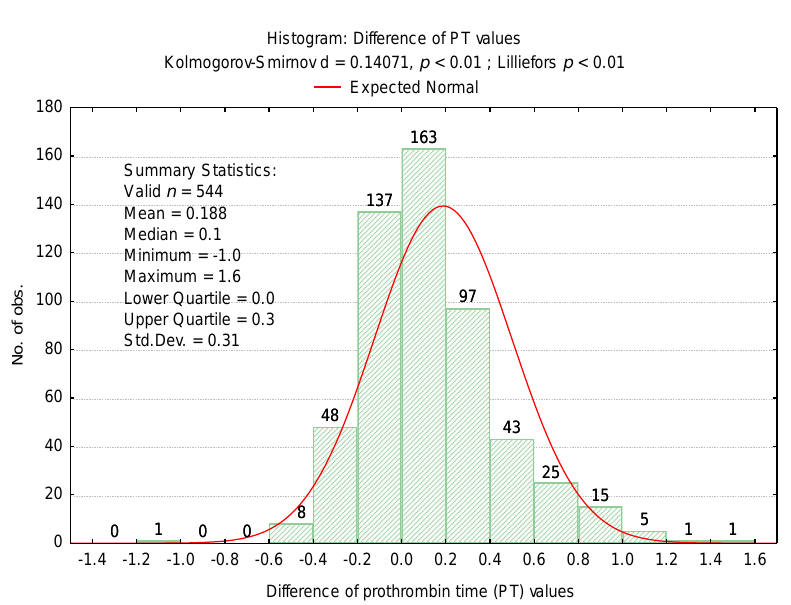
Figure 2. Histogram of differences between PT values.